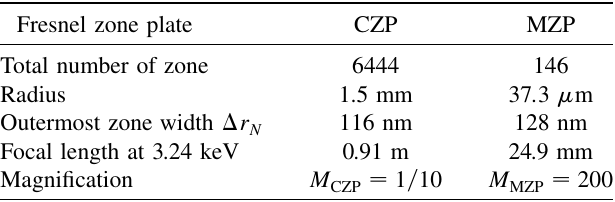
TABLE II. Specifications of the two FZPs.